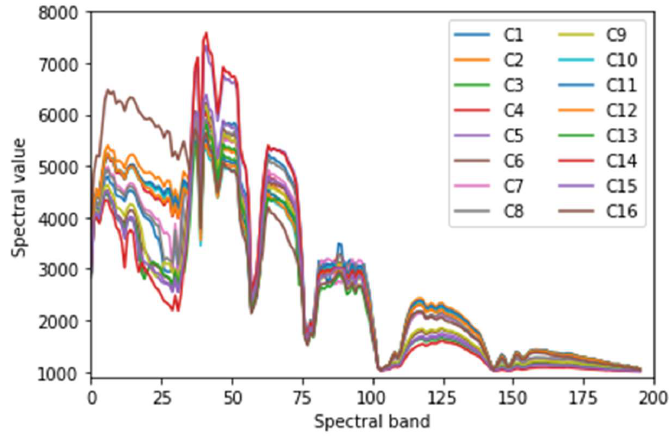
Figure 4. Mean spectral signatures of 16 classes in the Indian Pines dataset.